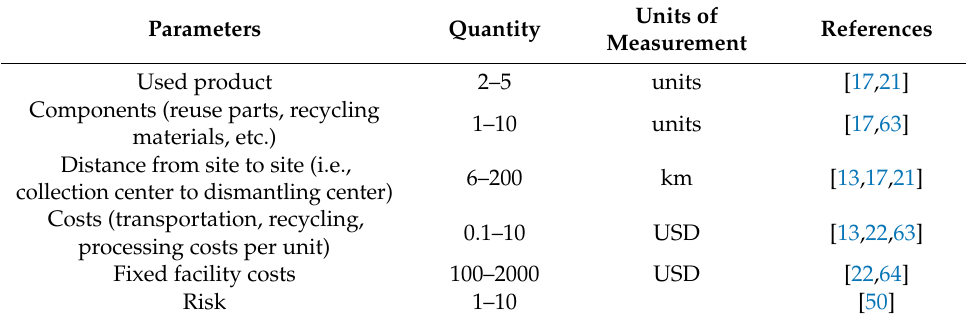
Table A1. Referenced data based on published papers. Parameters Quantity